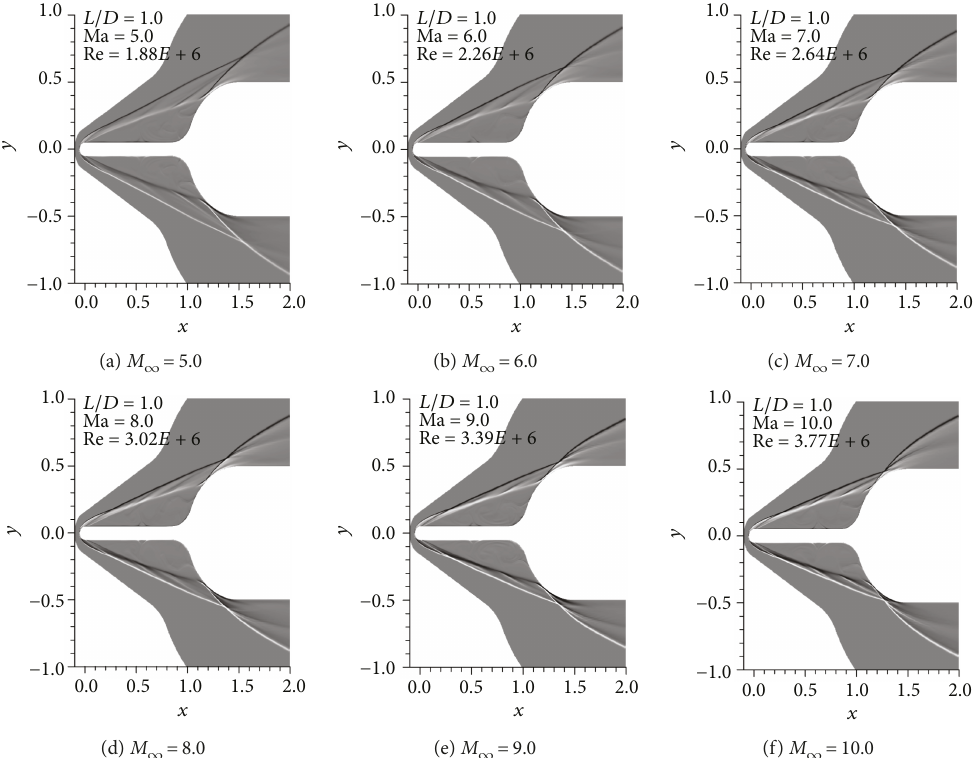
Figure 8: Flow fi eld density gradient in y direction of pure spiked blunt bodies. Spike length L/D =